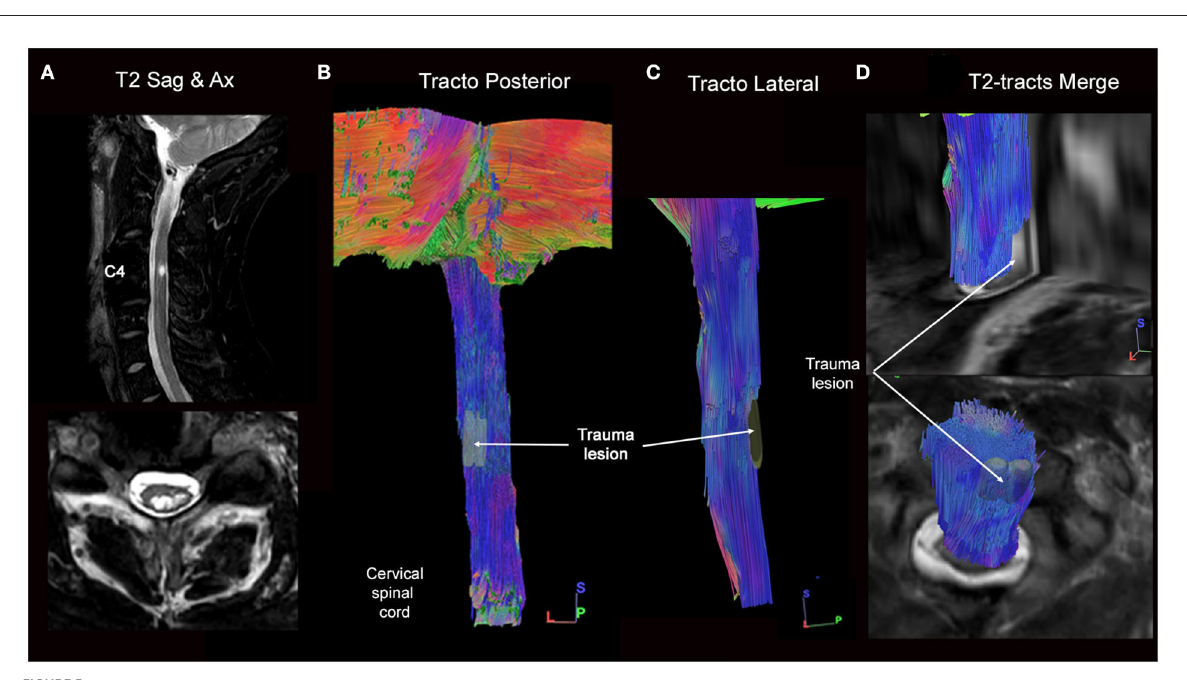
FIGURE5 Full cervical cord tractography in a patient with spinal cord injury. (A) Sagittal and axial T2-weighed images showing intramedullary hypersignal at the C3–C4 spine level. On an axial image, intramedullary T2-hypersignal is seen on the left dorso lateral part of the spinal cord. (B) Dorsal and (C) lateral views of spinal cord tractography showing the complete interruption of left dorso-lateral spinal cord fibers. (D) Overlay of the spinal cord tractography on the sagittal T2-weighted MR images, where the correspondence between T2 hypersignal and fibers loss was perfectly